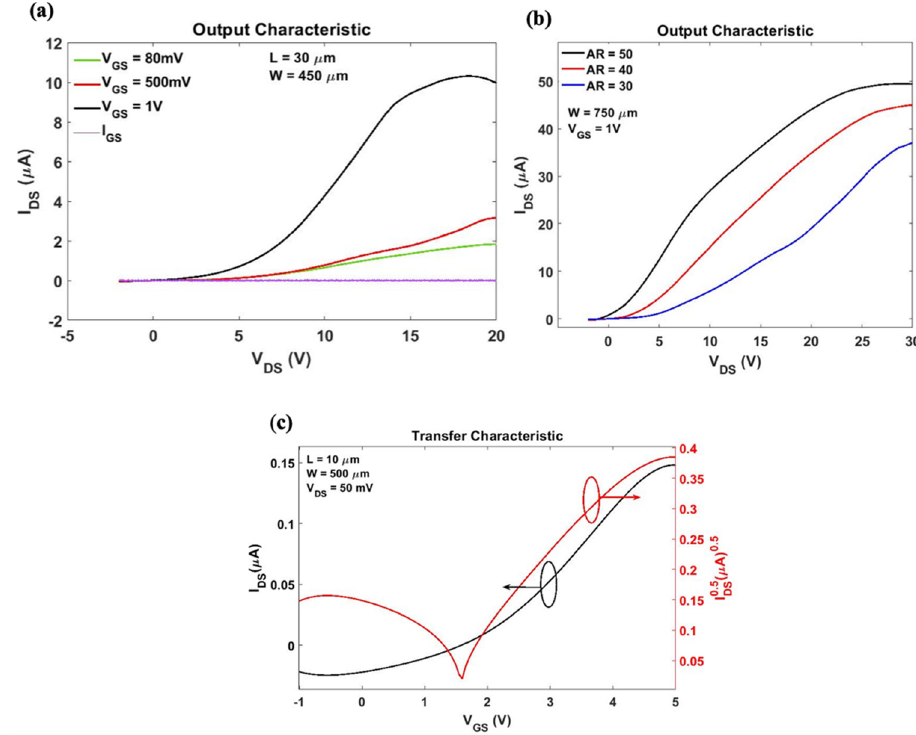
Figure 6. OTFT electrical characterization results: ( a ) Output characteristic at constant gate bias V GS range from 80 mV to 1 V, ( b ) parametric sweep of output characteristic against OTFT aspect ratio at V GS = 1 V, ( c ) transfer characteristic at V DS = 50 mV where I DS and √ I DS are used for estimating threshold voltage, carrier mobility, and current ON/OFF ratio.